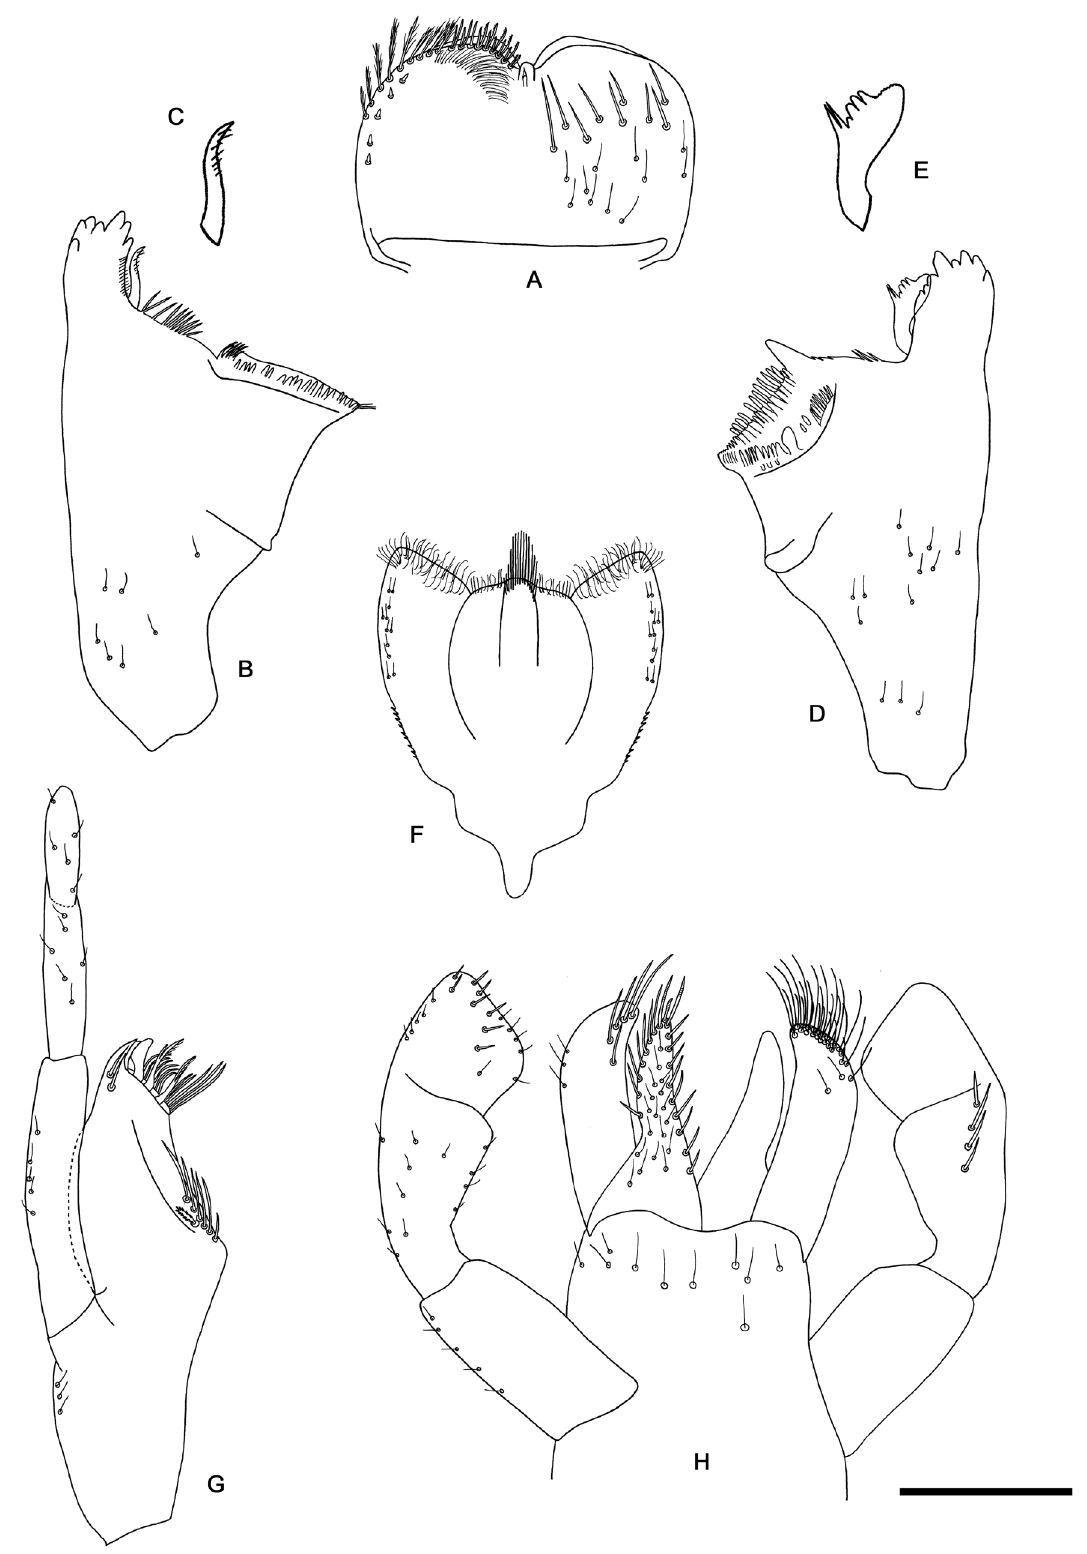
Fig. 5. Procerobaetis petersorum gen. et sp. nov., larval morphology. A . Labrum. B . Right mandible. C . Right prostheca. D . Left mandible. E . Left prostheca. F . Hypopharynx. G . Maxilla. H . Labium. Scale bar: 0.1